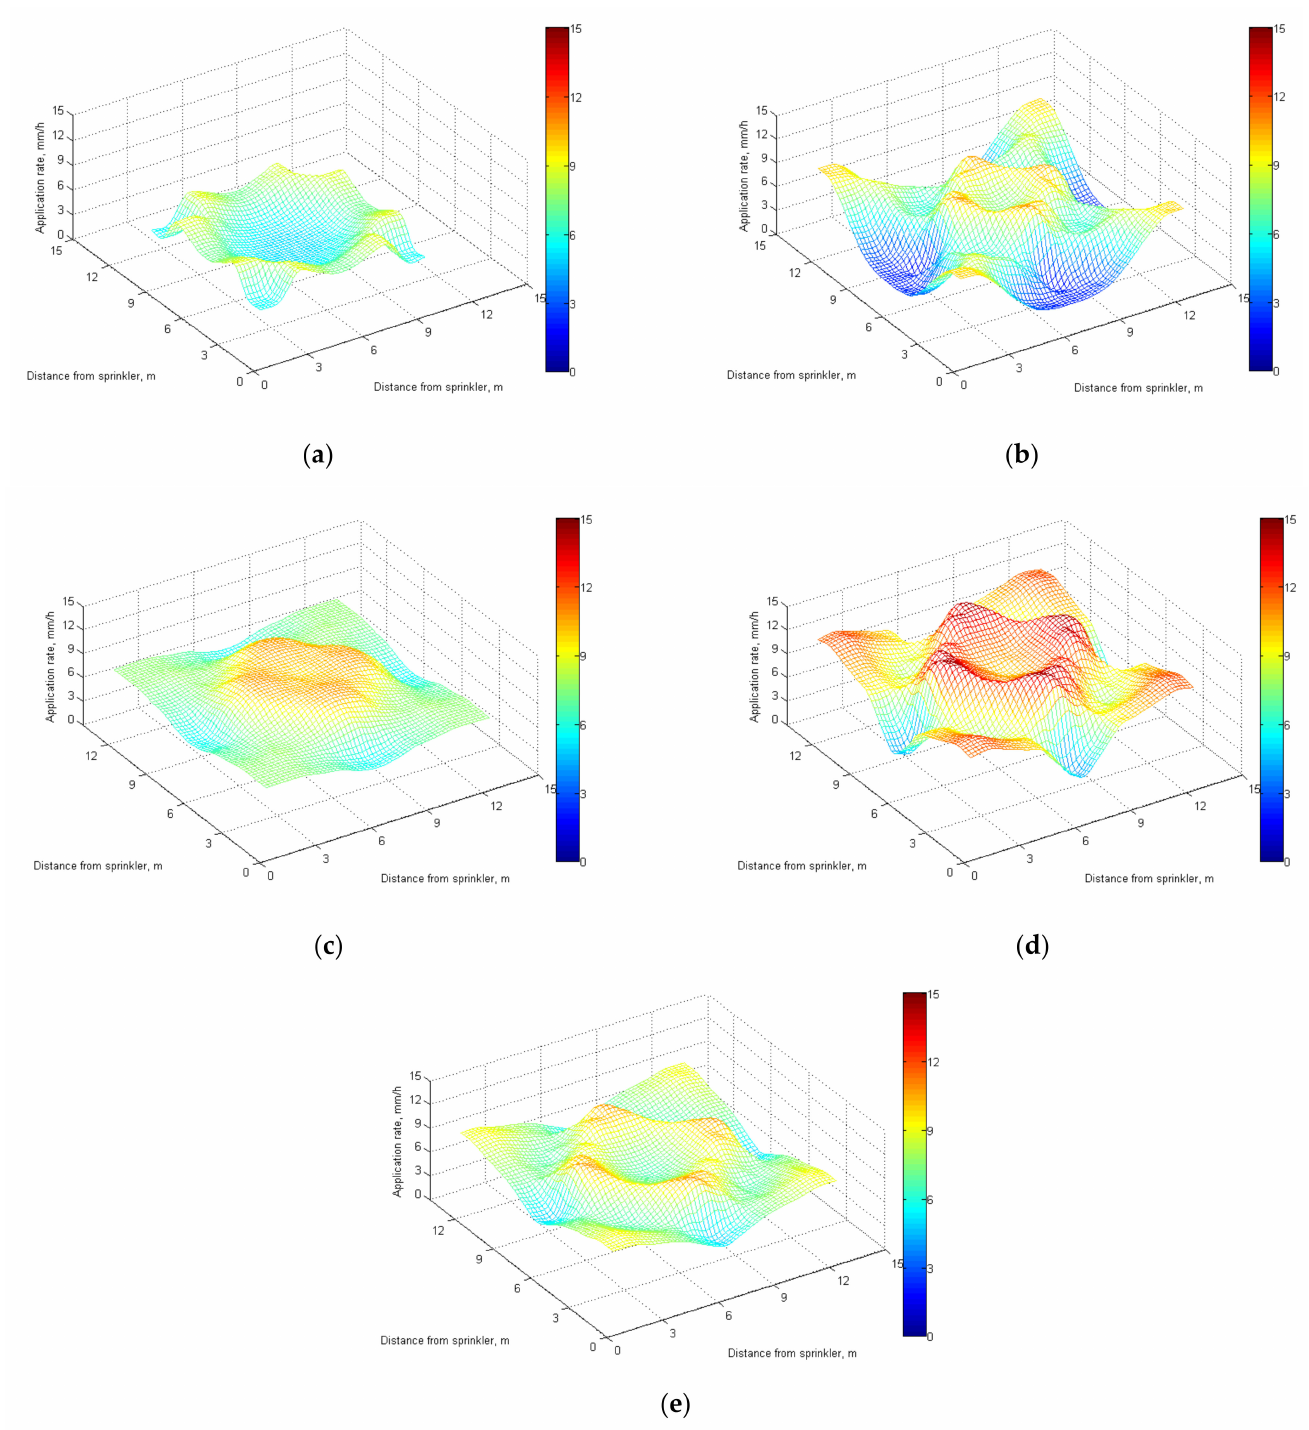
Figure 12. Water application rate for the three nozzle sizes under the different conditions. ( a ) D = 4.4 mm, 200 kPa, 9 m; ( b ) D = 4.4 mm, 200 kPa, 12 m; ( c ) D = 4.4 mm, 400 kPa, 12 m; ( d ) D = 4.8 mm, 200 kPa, 12 m; ( e ) D = 5.2 mm, 200 kPa, 12